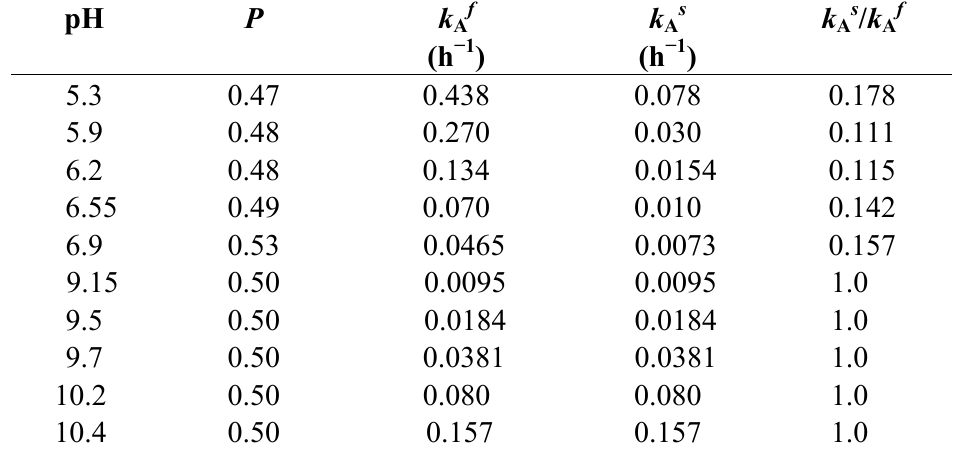
s / k f versus pH plot for human HbO Figure 3. A k A A the best-suited fitting under the assumption that a single, dissociable group, AH with K can be involved in the reaction. This was achieved with the setting p K